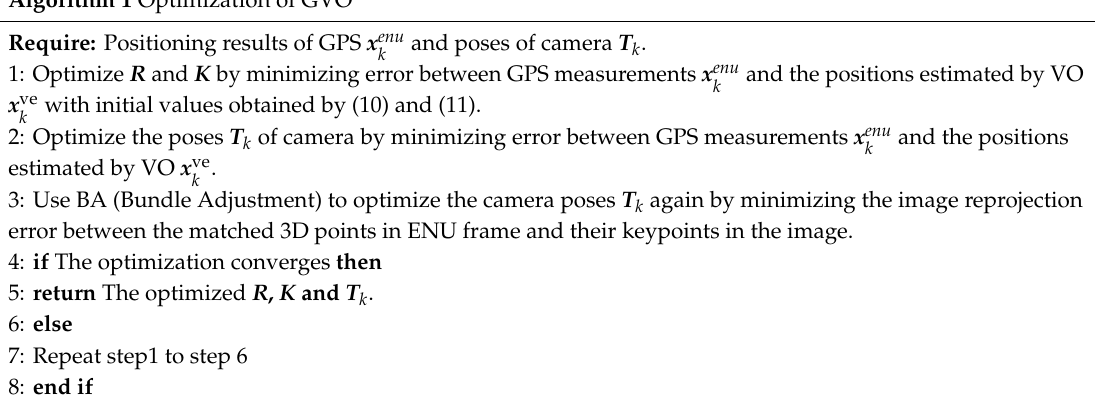
Algorithm 1 Optimization of